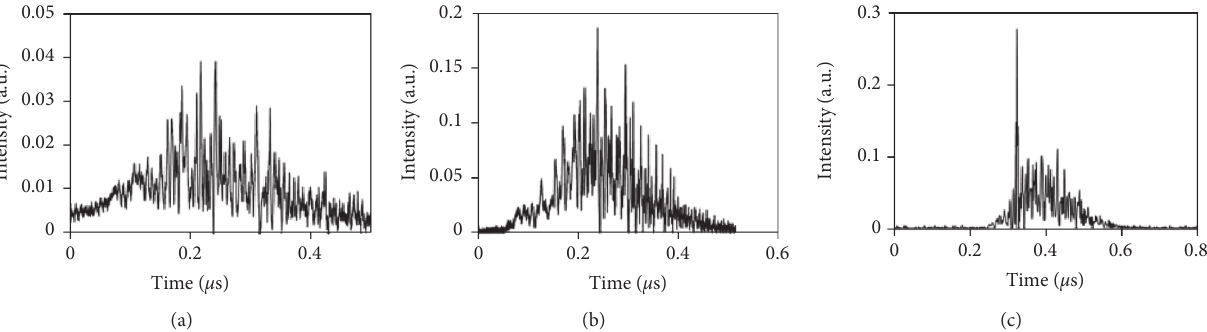
Figure 6: Q-switched and mode-locked pulses (cavity length 20 cm, SESAM R � 97%): (a) Cr 4+ :YAG T � 90%; (b) Cr 4+ :YAG T � 80%; (c) Cr 4+ :YAG T �